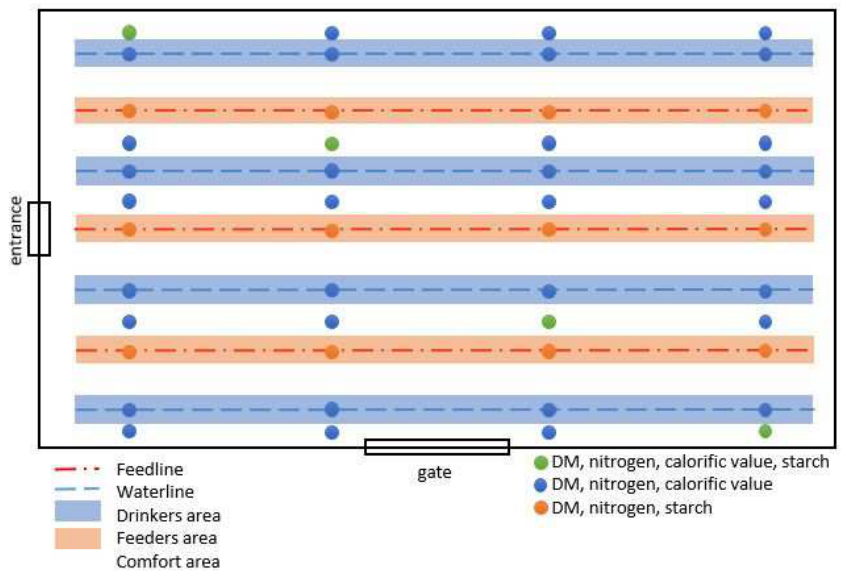
Figure 3. Shown is the sampling plan of the control barn. The blue (dashed) and red (dash-dotted) lines are the water and feeding lines. Therefore, the blue and red areas are the drinker and feeder areas. The white space is the comfort area. The green sample points were analyzed for DM, nitrogen, calorific values and starch, whereas the blue sample points were analyzed for DM, nitrogen and calorific values. The red sample points were analyzed for DM, nitrogen and starch.